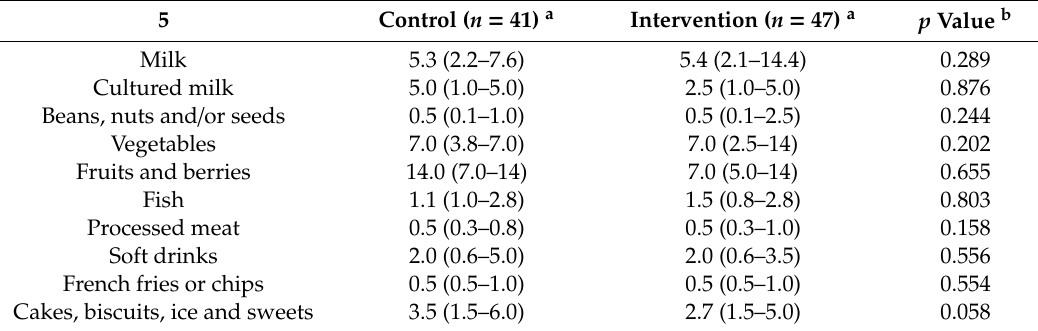
Table A2. Baseline dietary intake (frequency per week) of subjects in the pilot